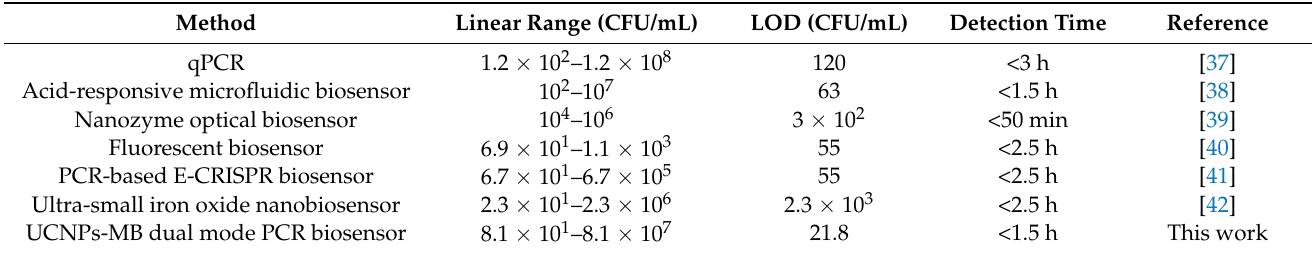
Table 1. Comparison between the developed UCNPs-MB PCR dual-mode biosensor for Salmonella and other reported methods.